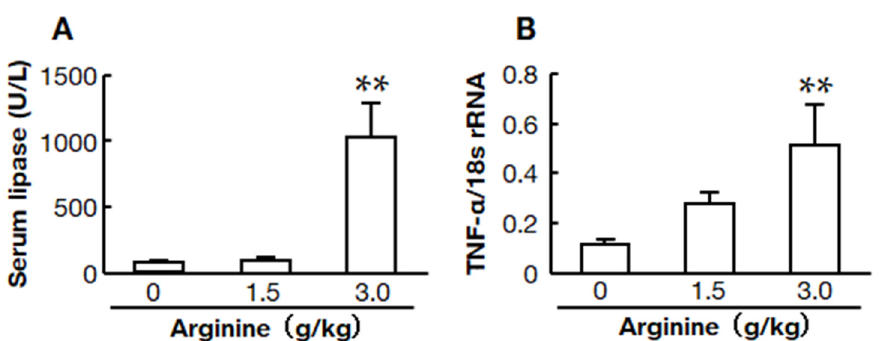
Figure 1. Dose responses of L-arginine on serum lipase and pancreatic TNF- α mRNA levels. Serum lipase ( A ) and pancreatic TNF- α mRNA levels ( B ) in hamsters 12 h after injections of 0, 1.5, and 3.0 mg/kg L-arginine (0 mg/kg: n = 6, 1.5 mg/kg: n = 6, 3.0 mg/kg: n = 4). Values represent means ± SEM. ** p < 0.01 vs. 0 mg/kg of L-arginine.